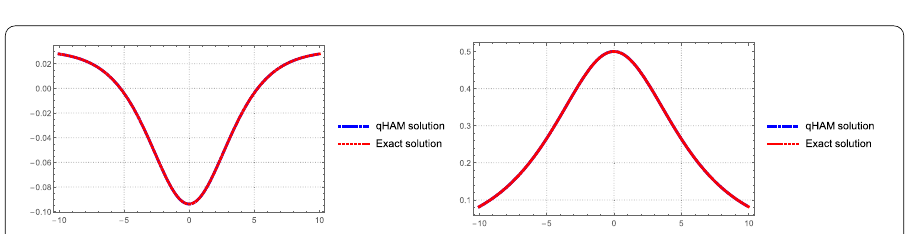
Figure 4 q-HAM vs. exact solution for Case I in 2D with λ = 0.5, α =